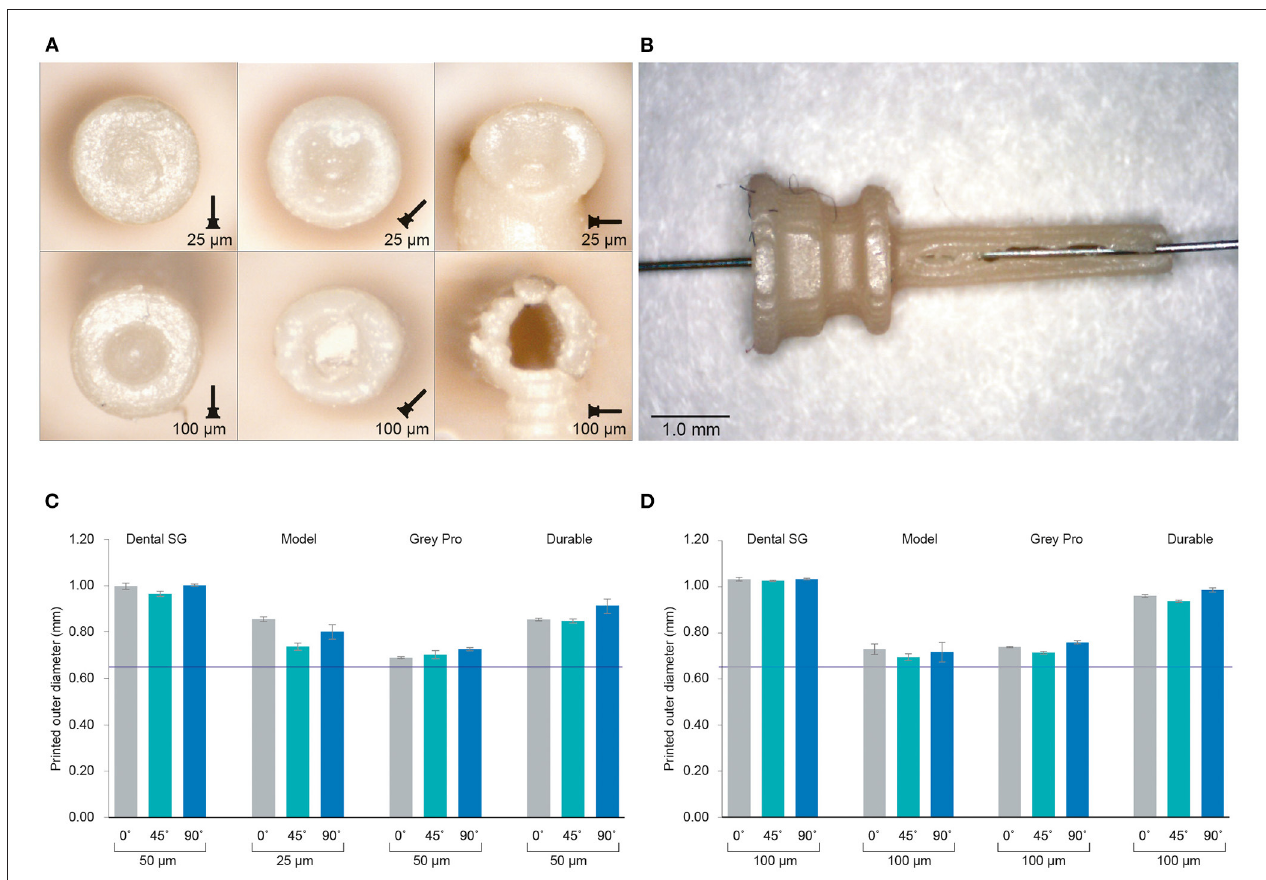
FIGURE 3 | Results of the investigation into different materials and print settings for the cannulas. (A) Example of the distal ends of the valves printed in Model, which was among the most successful materials, in different orientations and with different layer heights. For the cannulas in the 90 ◦ orientation, the support pillar is visible at the bottom. (B) Cannula printed in Model with 100 µ m layer height and open internal channel, although the wall is visibly torn. (C) The average outer dimensions of the channel given per material and per build angle for the smallest layer height setting per material. The purple line indicates the as-drawn dimensions of the outer channel. (D) The average outer dimensions of the channel given per material and per build angle for the largest layer height setting per material. The purple line indicates the as-drawn dimensions of the outer